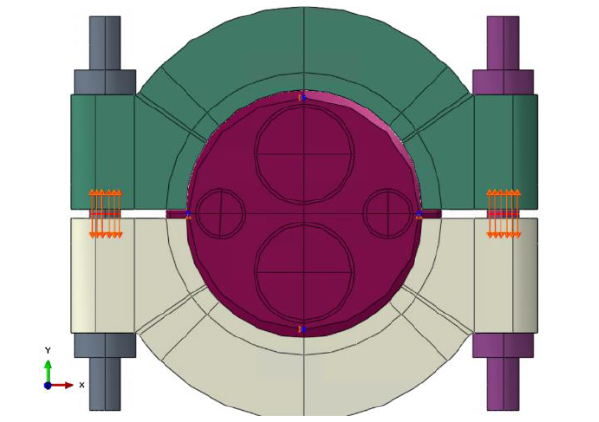
Figure 11. Bolt load model.